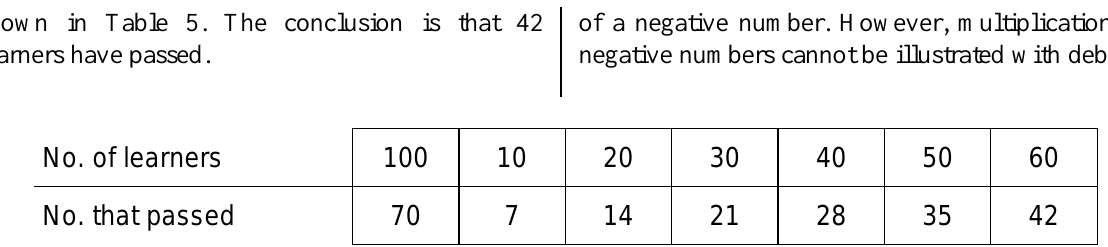
Table 4. A ratio table of fuel consumption